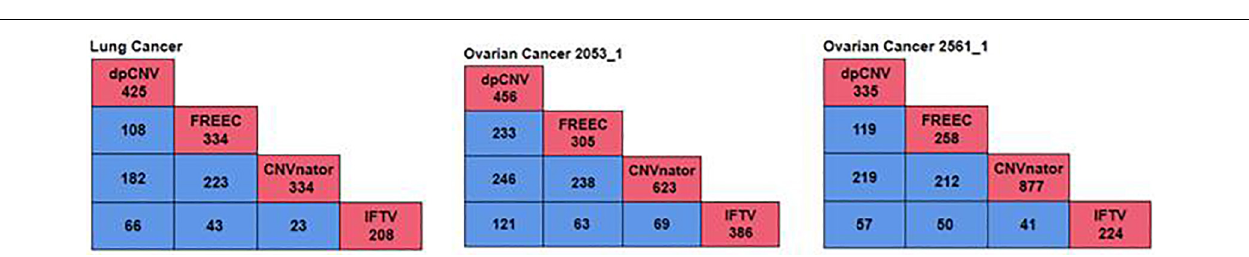
FIGURE 5 | The overlapping results of four methods on the three samples. The red boxes represent the total number of CNVs detected by each method, while the blue boxes denote the number of overlapping CNVs detected by any two methods.